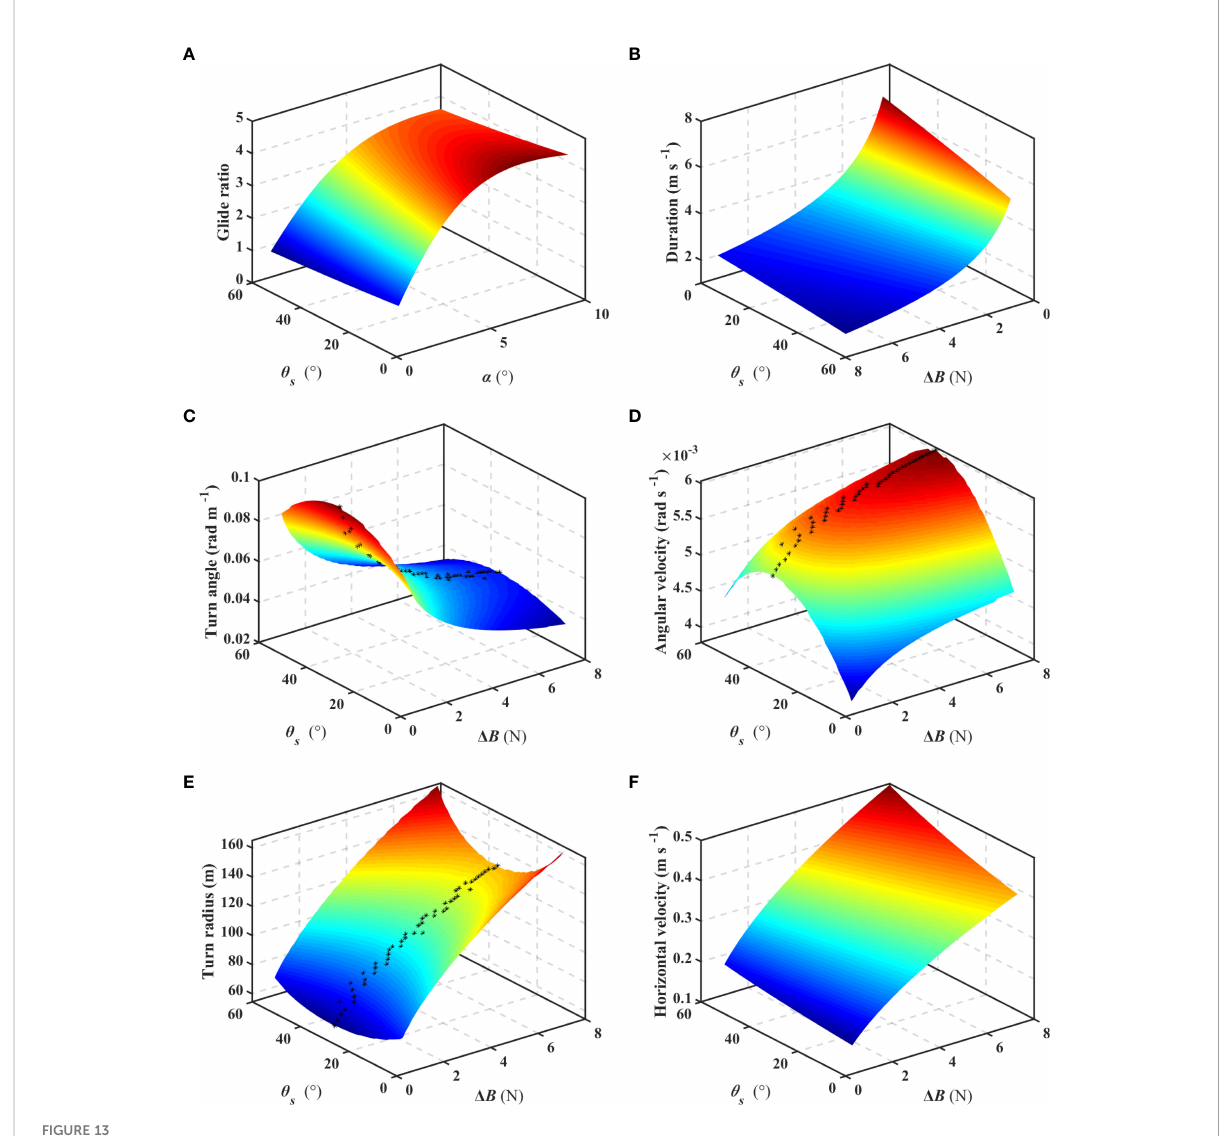
FIGURE 13 The indexes of UG with pre-adjustable sweep